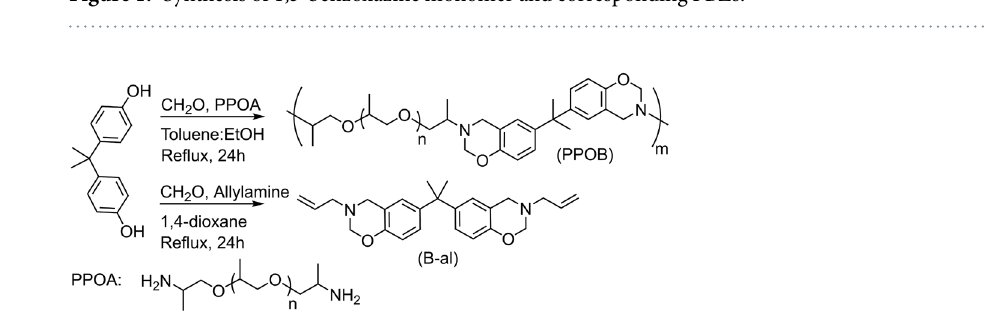
Figure 1. Synthesis of 1,3-benzoxazine monomer and corresponding PBZs.